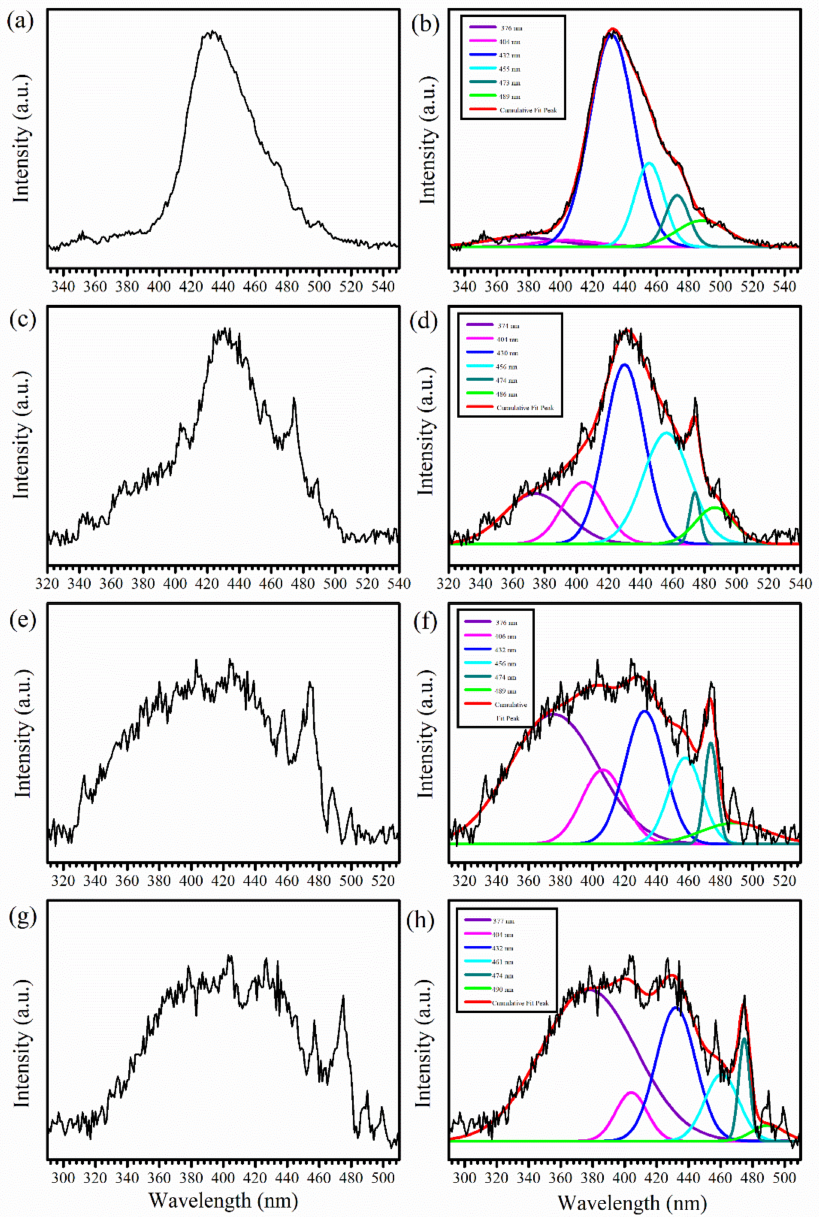
Figure 7. PL spectra of the β -Ga 2 O 3 nanostructures prepared at 1000 ◦ C and 32 min at different λ ex of ( a ) 310 nm, ( c ) 300 nm, ( e ) 290 nm, ( g ) 270 nm, and the corresponding deconvoluted spectra showing emission bands in the UV (purple) and blue (404–406 nm: magenta; 430–432 nm: blue; 455–461 nm: cyan; 473–474 nm: dark cyan; 486–490 nm: green) regions at different λ ex of ( b ) 310 nm, ( d ) 300 nm, ( f ) 290 nm, and ( h ) 270